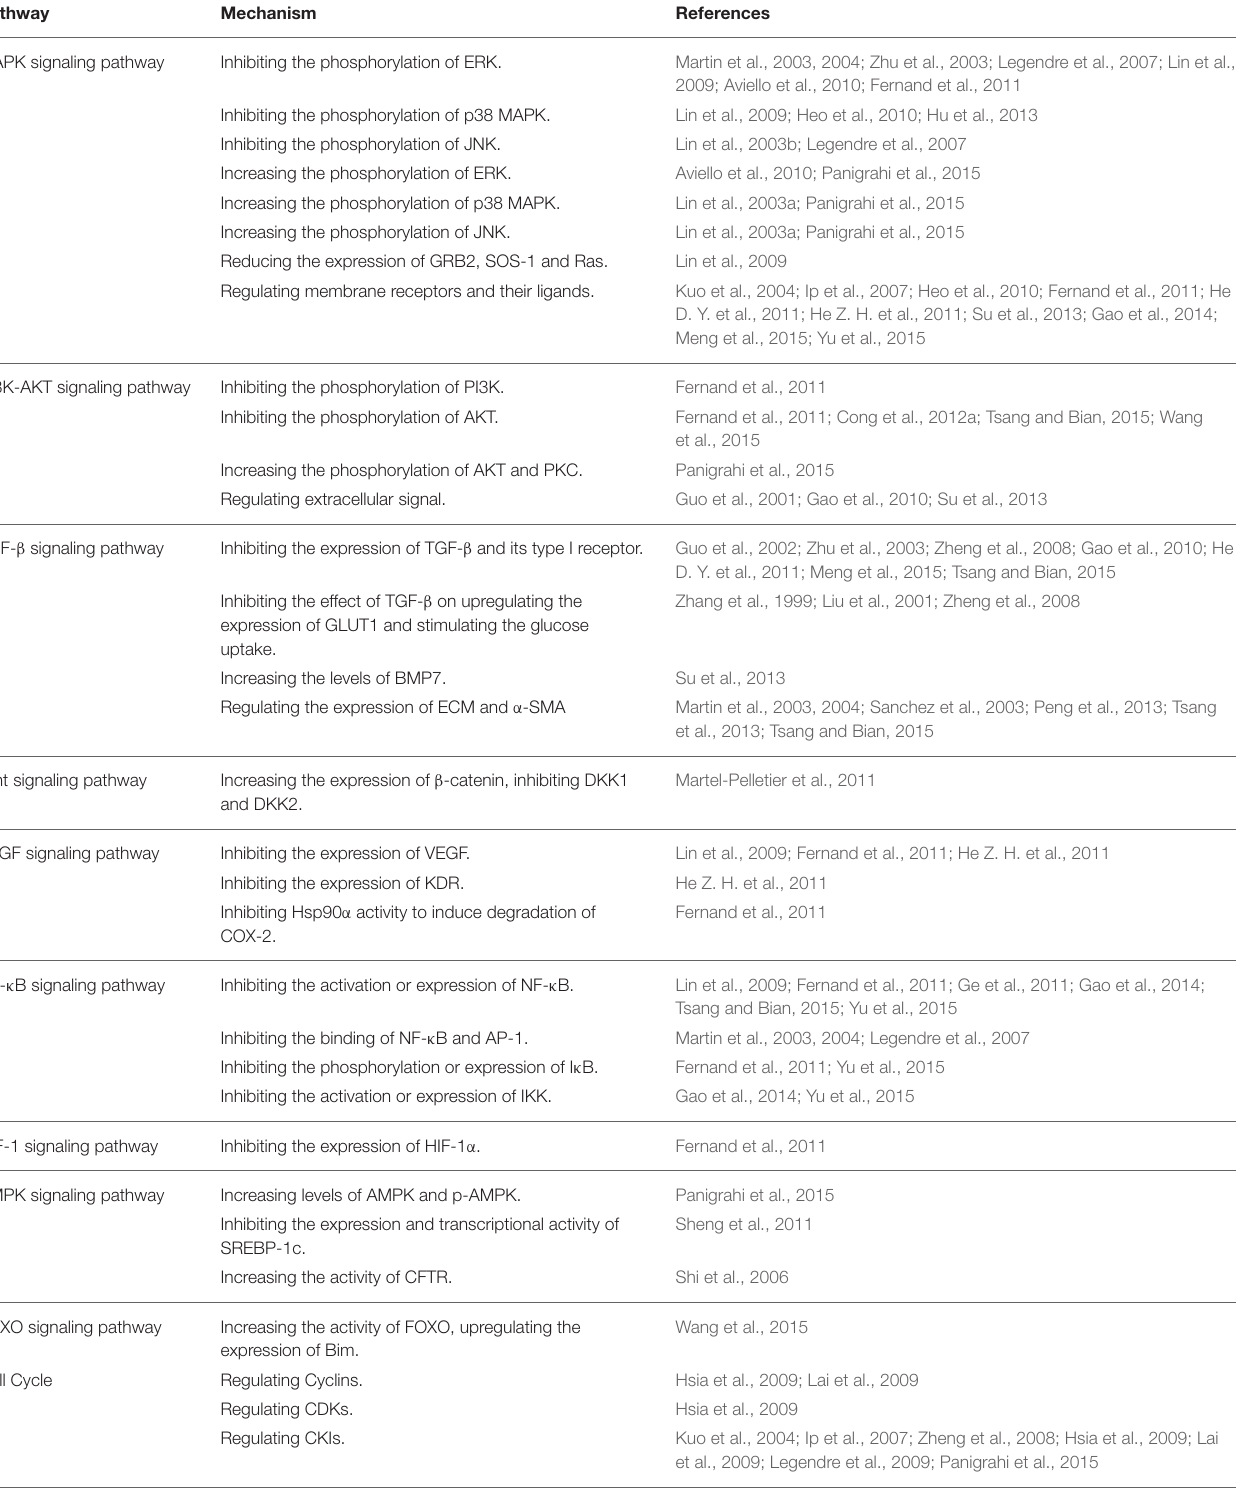
TABLE 1 | List of the pharmacological mechanism of rhein.